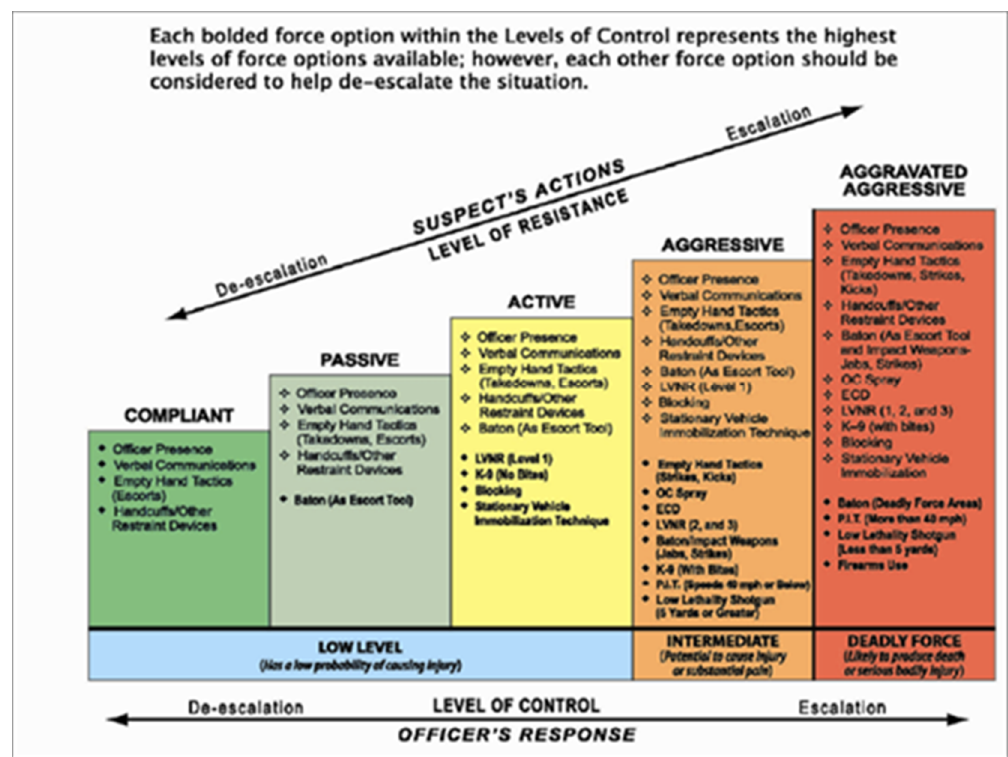
Figure 4. The Las Vegas Model. From [6] (p. 35) with permission from The Office of the Ombudsman of Ontario. All available versions of the Las Vegas Model are of poor resolution, limiting the clarity and interpretability of the presented text.